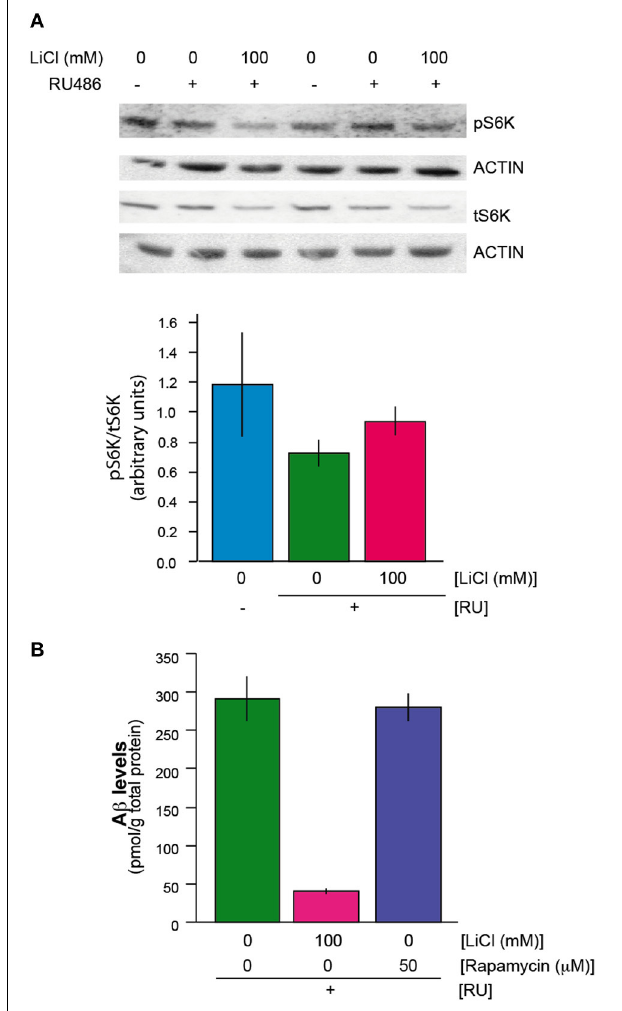
FIGURE 3 | (A) Lithium reduced protein levels of phosphorylated and total S6K. There was no change in the ratio of phosphorylated S6K to total S6K protein levels when UAS-ArcA β 42/ + ;elavGS/ + + RU + LiCl 100mM flies are compared to UAS-ArcA β 42/ + ;elavGS/ + + RU controls, P = 0 . 2 ( n = 3) (B) Rapamycin did not reduce A β levels in UAS-ArcA β 42/ + ;elavGS/ + + RU + 50 μ M flies in comparison to UAS-ArcA β 42/ + ;elavGS/ + + RU untreated flies, P = 0 . 8 ( n =